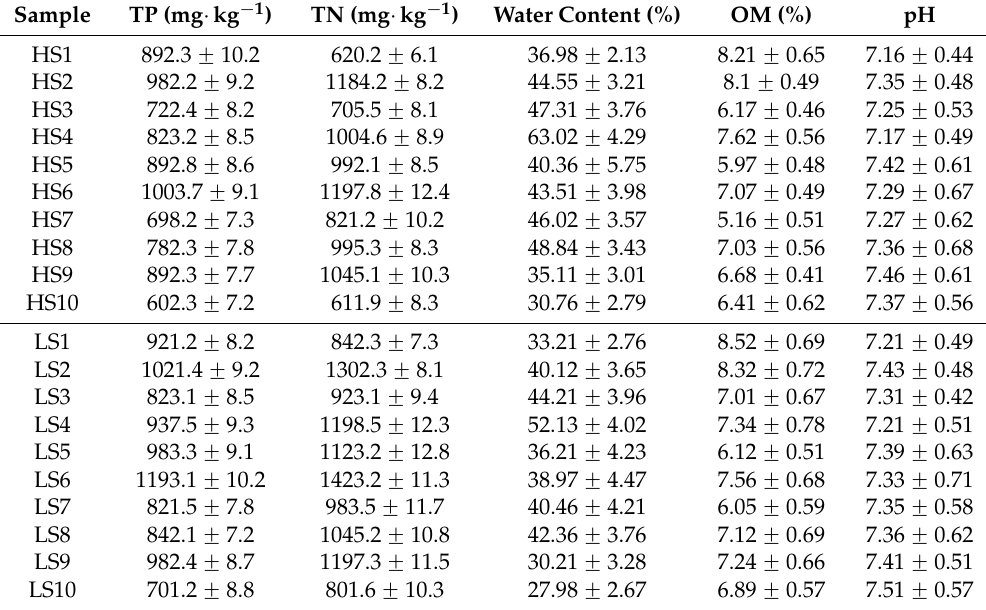
Table 1. Physicochemical properties (mean value ˘ standard deviation) of the